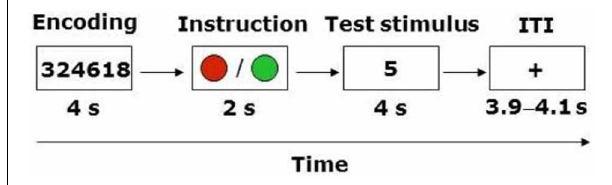
FIGURE 1 | Trial structure. ITI, inter-trial-interval. ITI varied between 3900, 4000, and